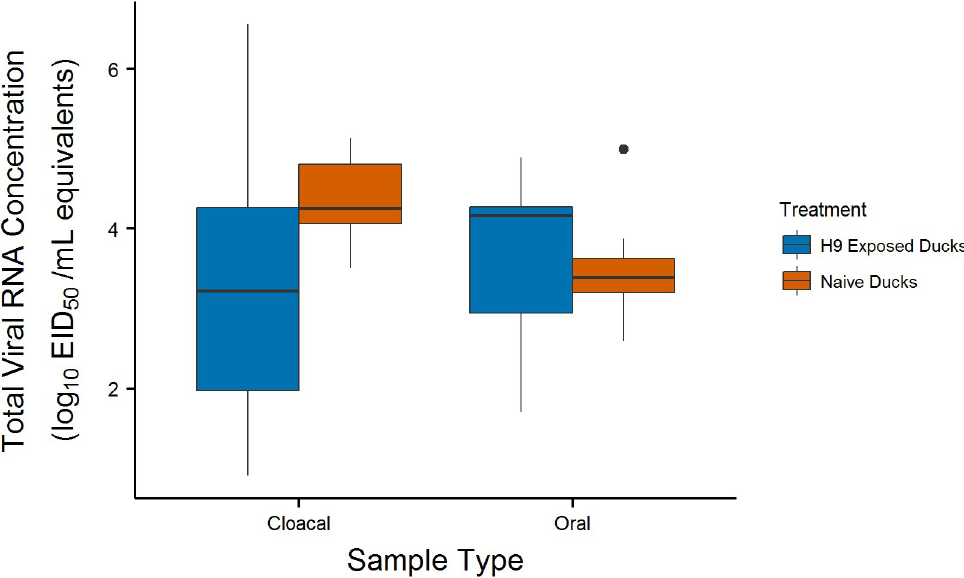
Fig 2. Heterosubtypic Immunity. Box plots summarize the distributionof total viral sheddingin oral/cloacal swabs taken from the H9-exposedcontrol group and na ï veducks from another study [22]. Boxes show the interquartile range (IQR, middle50% of values)for each group, horizontal lines represent medians,and vertical lines are values within 1.5 * IQR. Outliers are plotted as individual points.